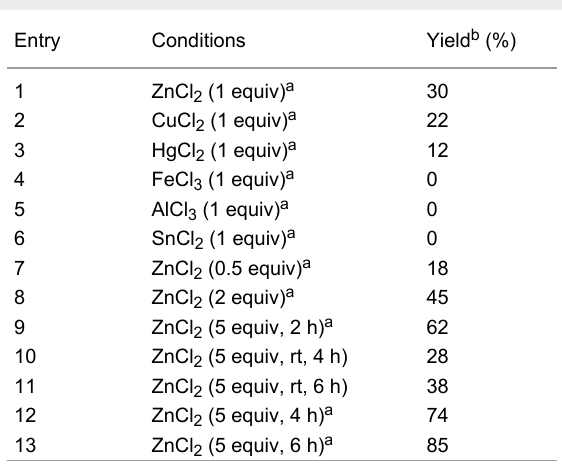
Table 2: Effect of catalysts in the yield for synthesis of 2a a .